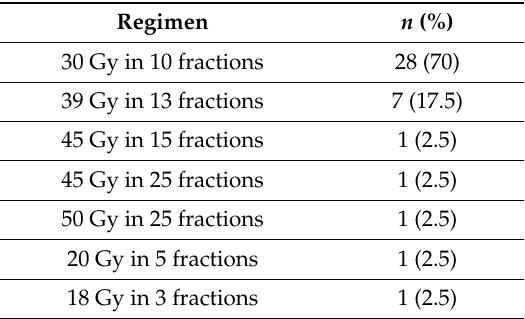
Table A1. RT regimens